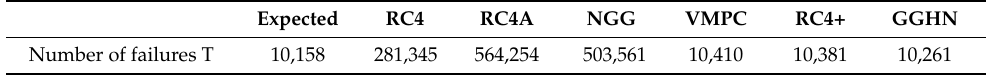
Table 3. Expected value and observed values for each encryptor in